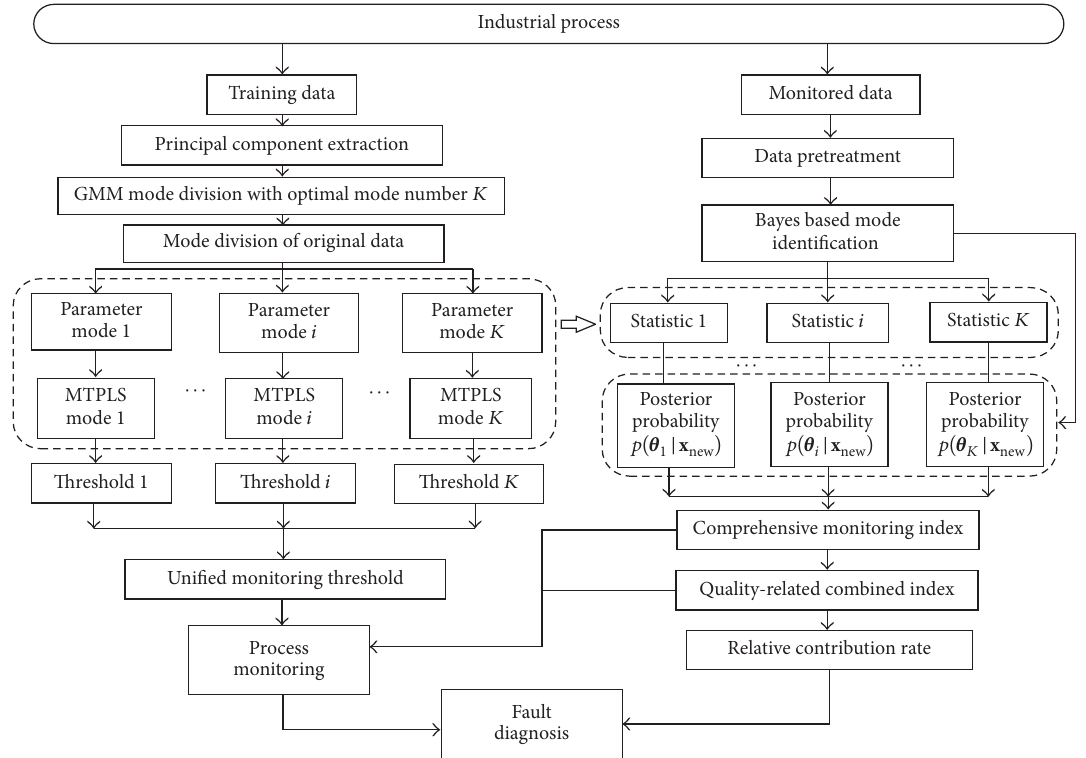
Figure 1: Schematic diagram of the proposed PLS-MTPLS and Bayesian-based process monitoring and diagnosis